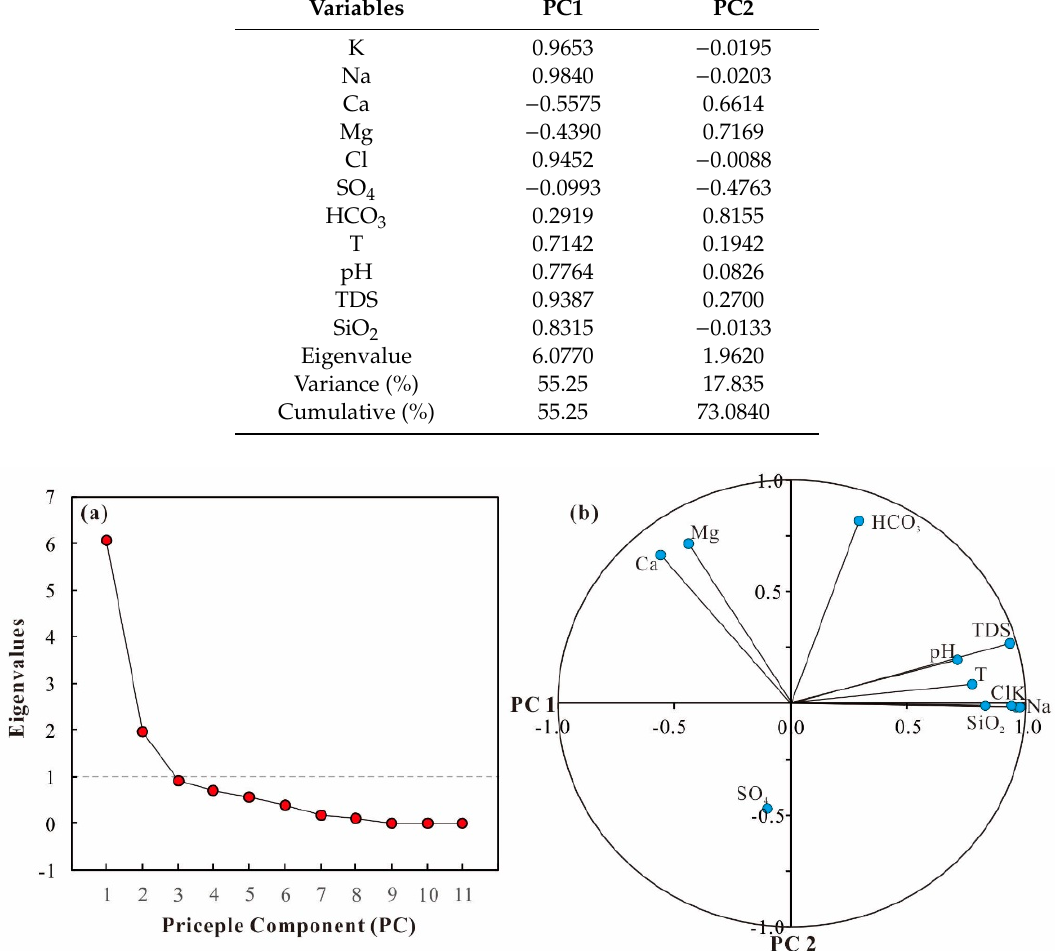
Table 1. Factor loadings and eigenvalues of the eleven extracted factors.